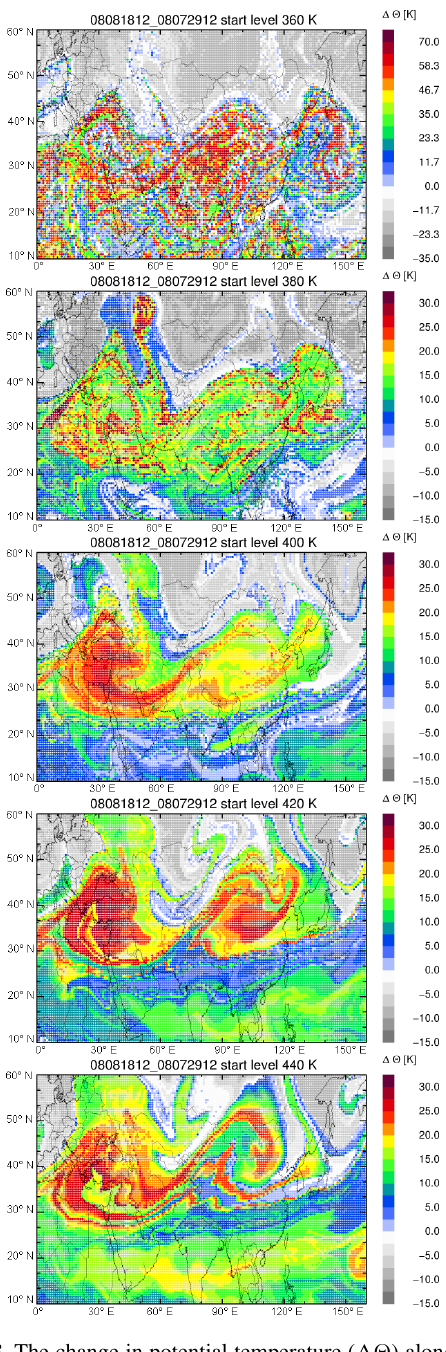
Figure 8. The change in potential temperature ( (cid:49)(cid:50) ) along 20-day backward trajectories initialised on 18 August 2008 is shown for different levels of potential temperature (360, 380, 400, 420, and 440K). Note that the range of the colour bar in the first panel is much larger than in the other panels. At the lower potential temper- ature levels (360, 380K), some 20-day backward trajectories exist that reach the model boundary layer within a time period shorter than 20 days (in cases of very strong uplift by convection). For these trajectories (cid:49)(cid:50) is shown for the shorter time